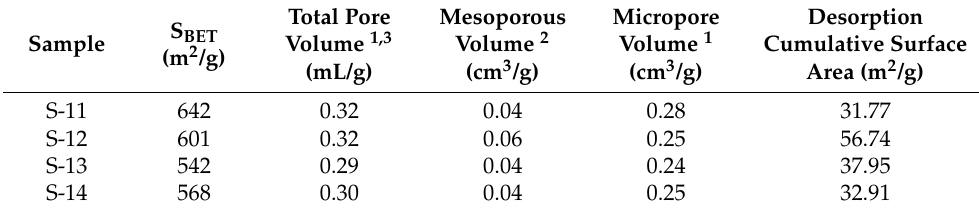
Table 3. N 2 physical adsorption data of S-11, S-12, S-13 and